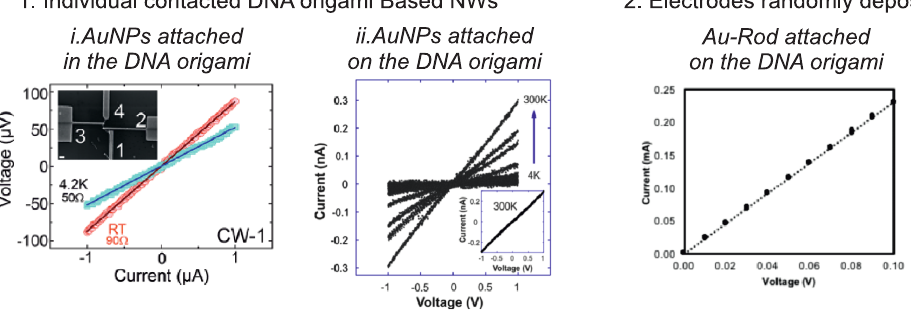
Figure 3. Examples of I ( V ) -curvestaken for the nanowires shown in Figure 2. ( a )wires that were created by activation and subsequent electroless deposition. Images are taken with permission from [12] (Ag), [18] (Au), and [11] (Pd); in case of Pd, a measurement after cutting the NW is shown (triangles). ( b ) electrical characterization of suspended nanowires which were metalized by direct Au evaporation. Image is taken with permission from [20]. Linear I - V curves at low bias prove the feasibility of Au coated DNA NWs for electrical circuits with resistances of around 30 ( 140 ) Ω for thick (thin) NW; ( c ) electrical characterization of an array of AuNPs, which was formed by connections between RNA-functoinalized Au nanoparticles. I ( V ) -curvesshows thermally activated charge transport. I - V curves at high temperatrues show linear behavior, however at 100 and 130 K characteristics can be compatible with single electron phenomena.Image taken with permission from [41]; ( d ) electrical characterization of nanowires formed on DNA Origami. Images are taken with permission from [38] (left), [36] (center), and [37]. Temperature dependent I - V characterization of origami mold templated AuNW (contacts 1 and 2 in the SEM image in the inset, 3 and 4 show insulating behavior) shows metallic conductance in i . Temperature dependent electrical characterization shows resistive wires of enhanced AuNPs on DNA nanotubes in ii. , which indicates the presence of small gaps between grown AuNPs. Anisotrophic nanorod growth in 2. shows nanowires with resistances lower than 2 k Ω